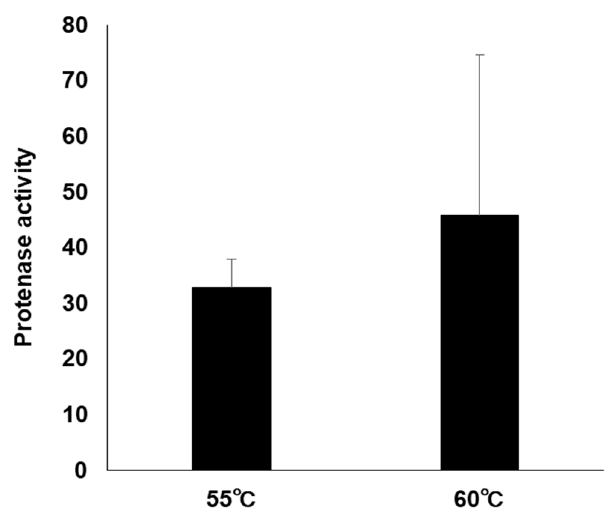
Figure 6. Specific activity of protease extracted from giant masu salmon in different temperatures. Values represent mean ( n = 3).